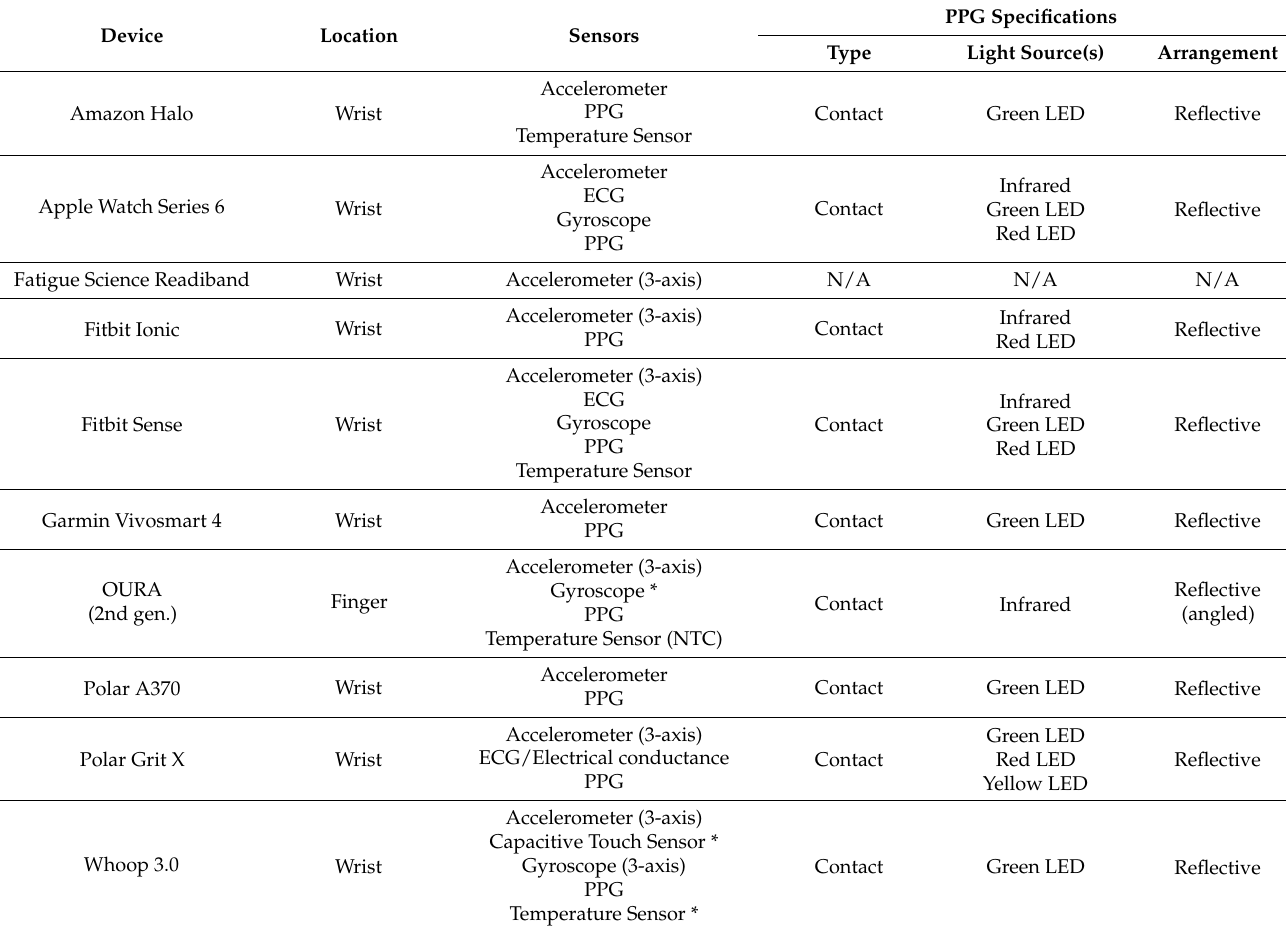
Table 1. This table includes device specifications for common commercially available wearable technologies that claim to assess sleep. Information regarding each device has been obtained via its respective company resources, where available for release, including specifications of the photoplethysmographic sensor, if applicable, for the device. It is important to note that while a sensor may be embedded in a device, it does not ascertain that it is used in sleep evaluation; sensors denoted by an asterisk (*) have been confirmed by company resources to not participate in sleep quantification efforts. Reflective arrangements of PPG sensor components listed as reflective are direct unless otherwise specified. (ECG, electrocardiography; gen., generation; LED, light emitting diode; N/A, not applicable; NTC, negative temperature coefficient; PPG,